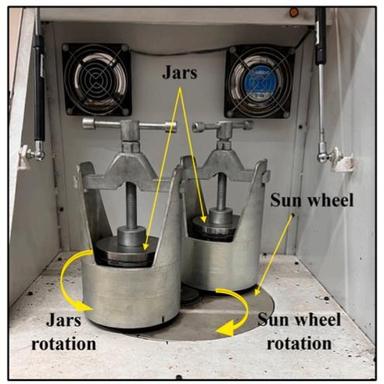
Interior of high energy ball milling machine with the jars arrangement over the sun disc.